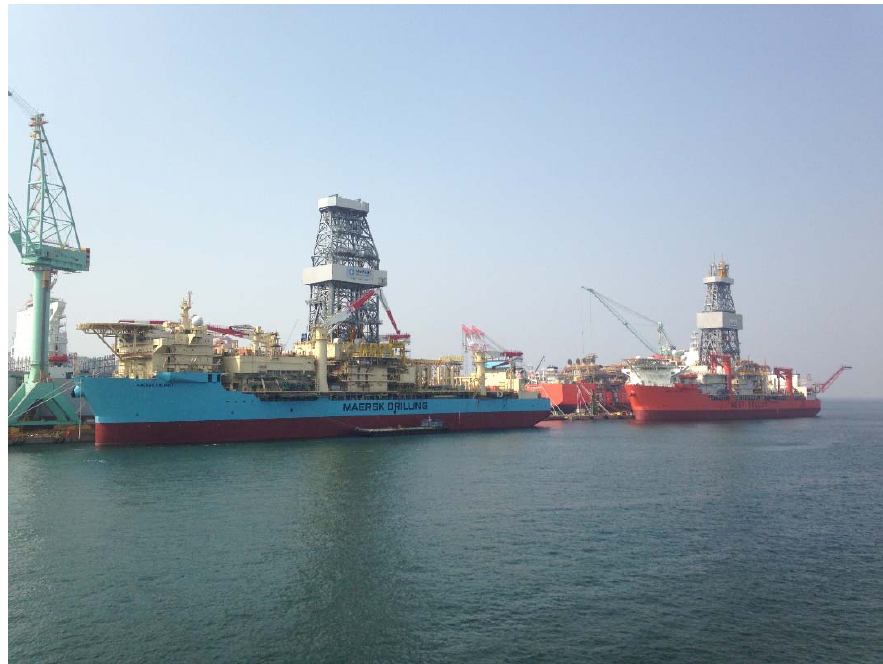
Figure 1. An ultradeep water class drillship.